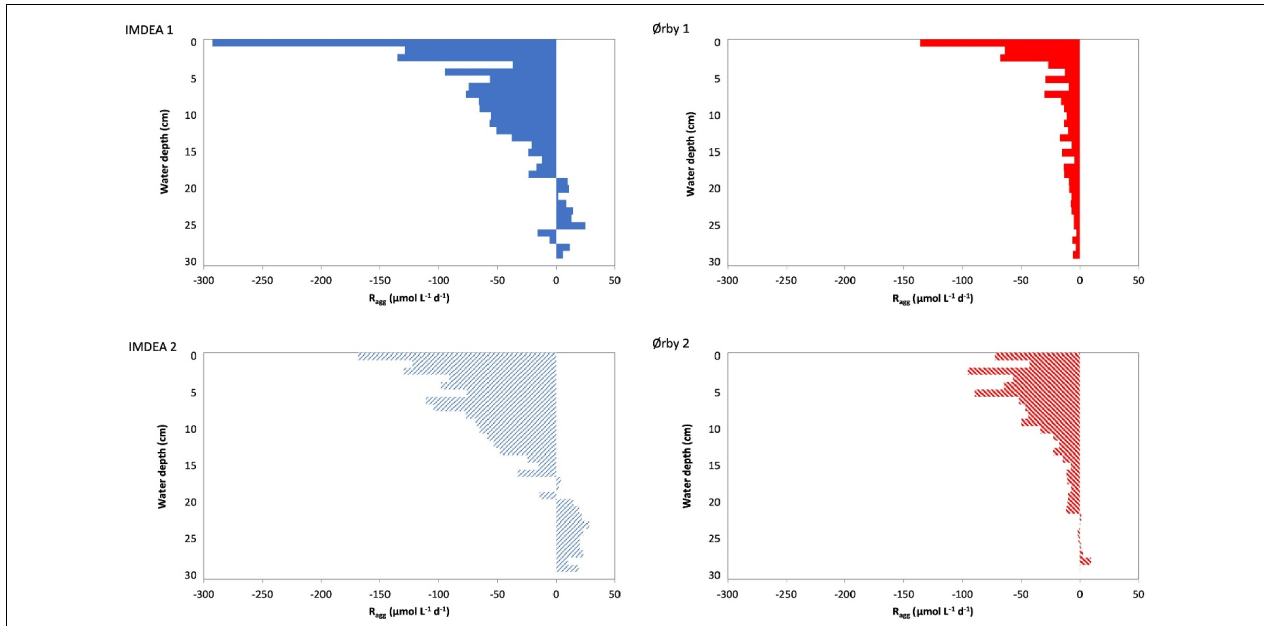
FIGURE 6 | Aggregated electron transfer rate ( R agg ) for METland units treating wastewater (i) from an office building (planted IMDEA 1 and non-planted IMDEA 2) and (ii) from an urban community (fully saturated Ørby 1 and partially saturated Ørby 2). Positive values indicate zones where the bed is accepting electrons from an electron donor (anodic reaction), and negative values indicate zones where the bed is donating electrons (cathodic